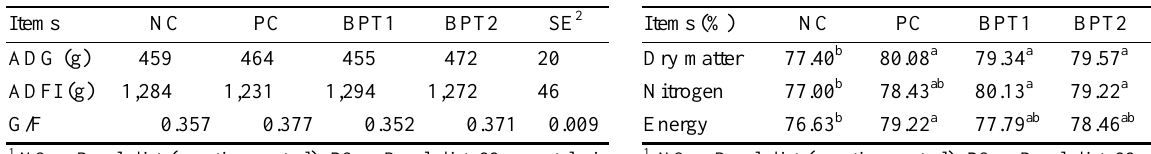
Table 3. The effects of bacterphage on nutrient digestibility